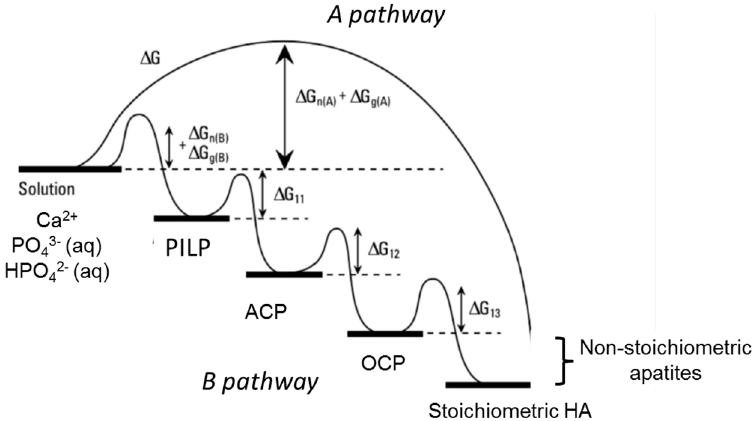
Figure 5. Gibbs free energy of activation associated with nucleation (n), growth (g) and phase transformation (T) through two main pathways: with ( B ) and without ( A ) intermediate phase(s) (adapted from Gower’s review paper for the calcium phosphate system [107]).